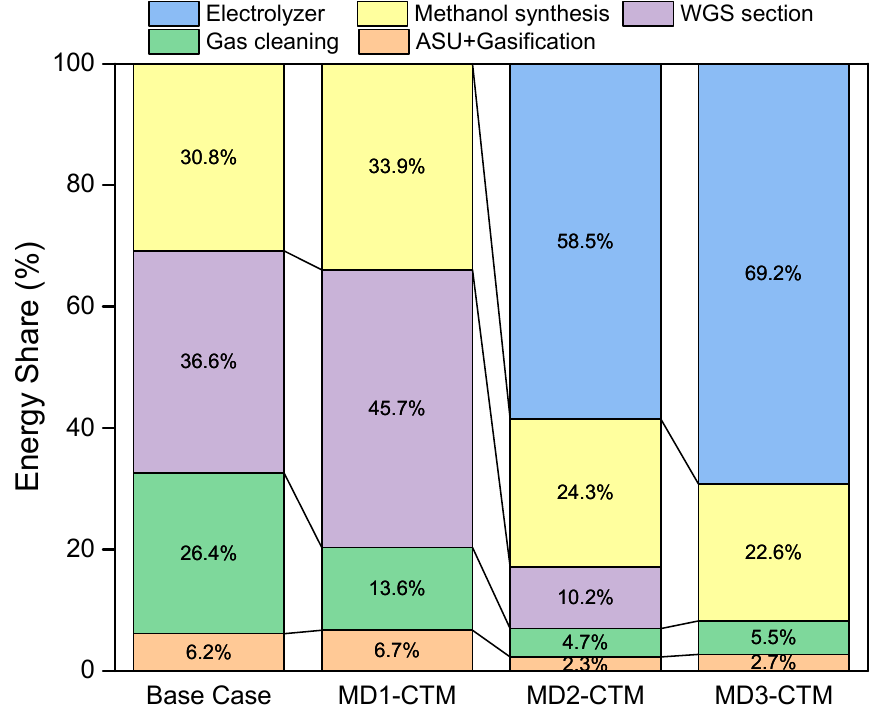
Figure 7. Breakdown of percent energy requirement for the four CTM processes.